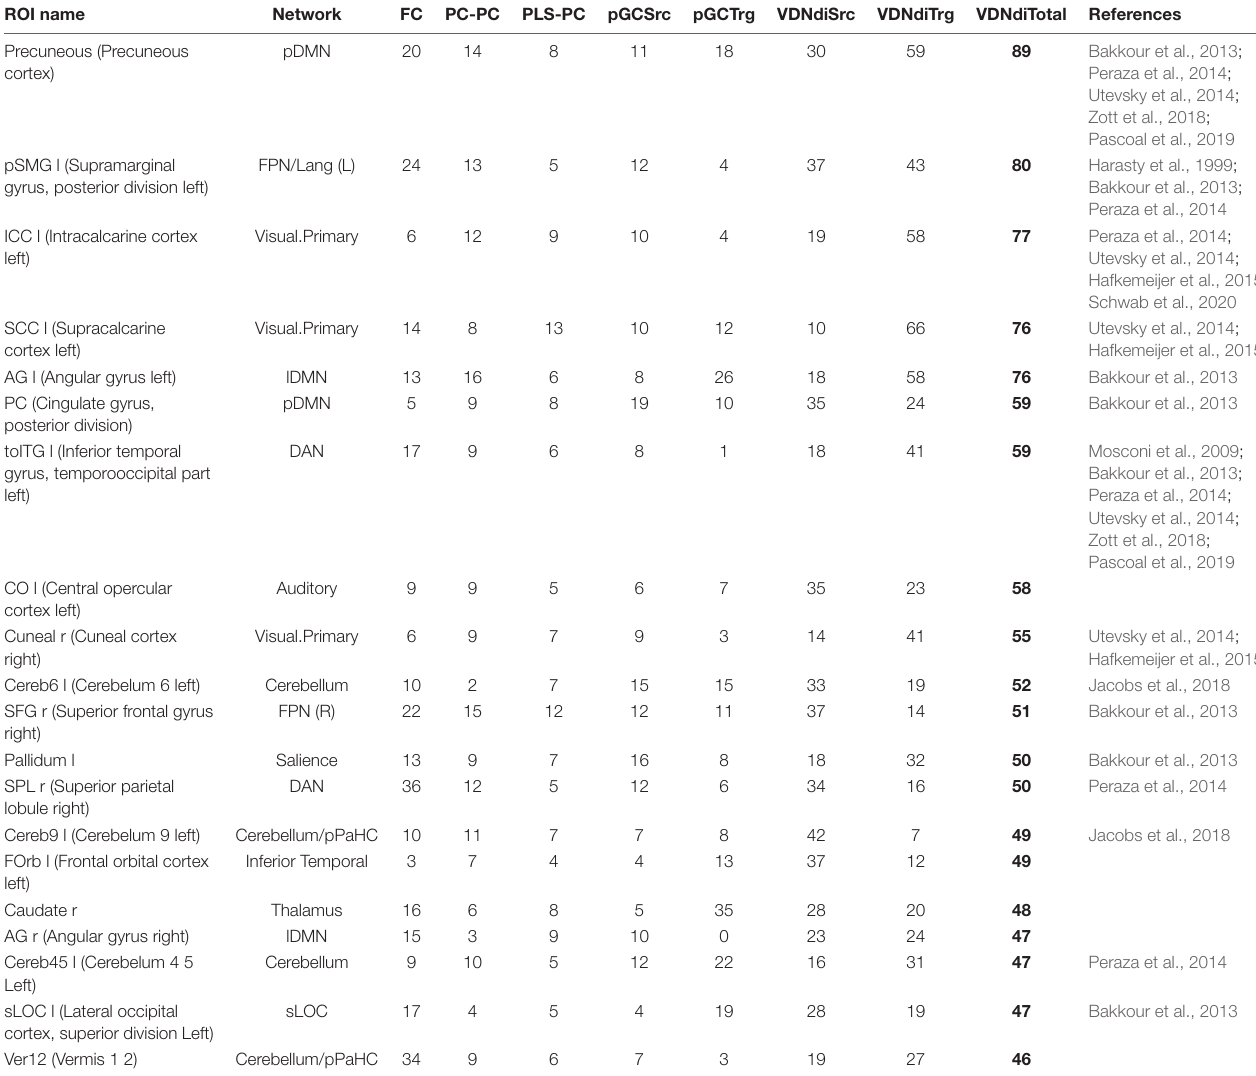
TABLE 3 | Top 20 regions of most different dFC between AD and HC, calculated from